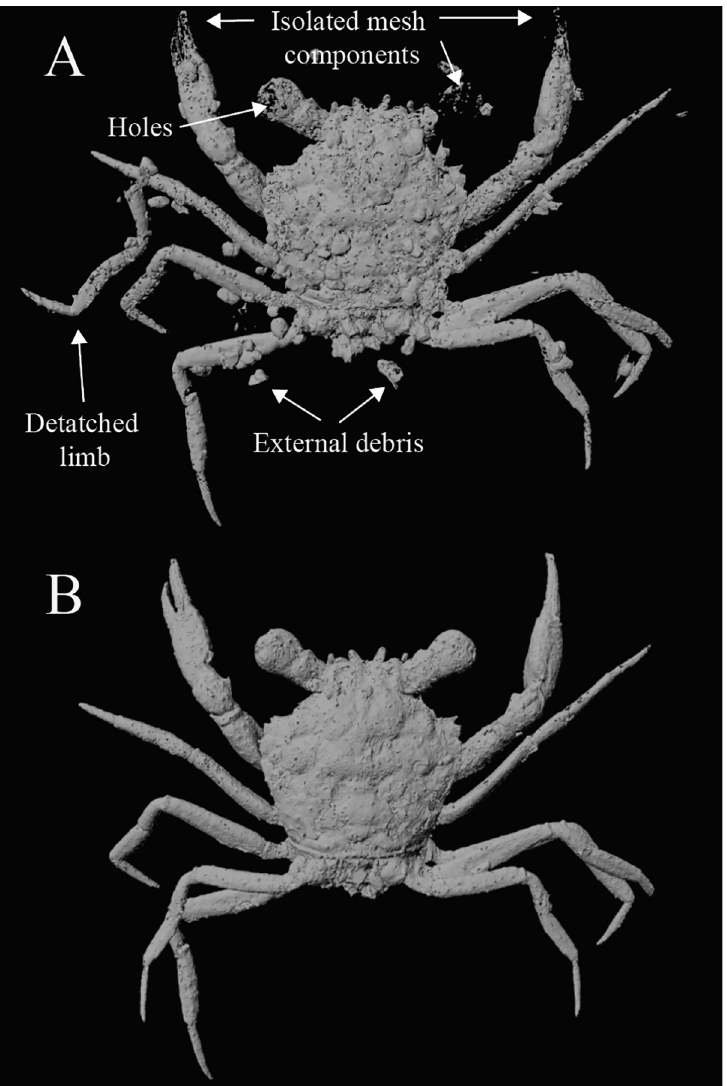
Fig 4. 3D reconstruction of Cretapsara athanata [5] before (A) and after (B) post-processing. (A) 3D mesh [5] exported directly from VG Studio MAX version 3.0. Object file exhibits many of the common issues described for fossil taxa, including the presence of external debris, disarticulated elements, isolated or missing mesh elements, holes, and irregular surfaces. (B) 3D mesh file post-processed in Meshlab and Autodesk Maya. Images generated using Autodesk